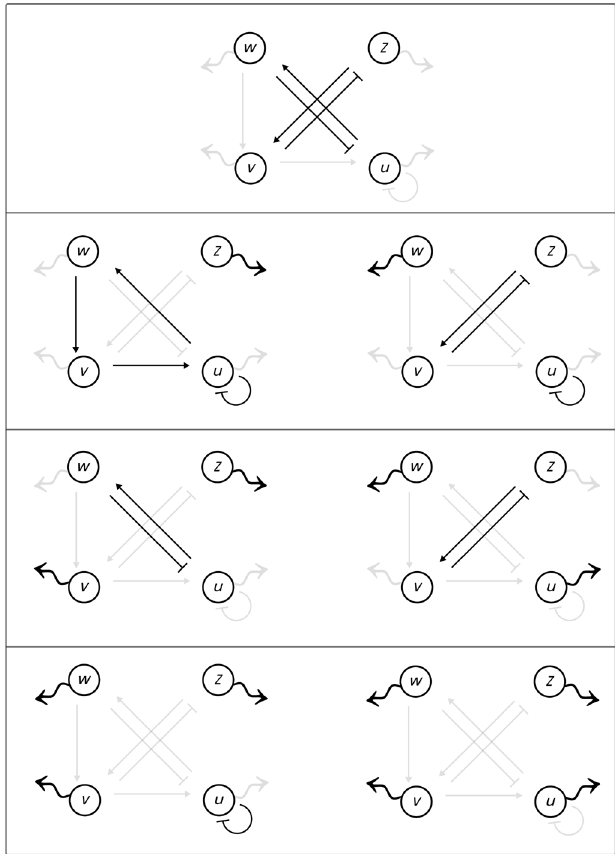
FIG. 8. l -subgraphs of size 4 contained in the network shown in Fig. 7, ordered in rows according to the number of diffusive loops